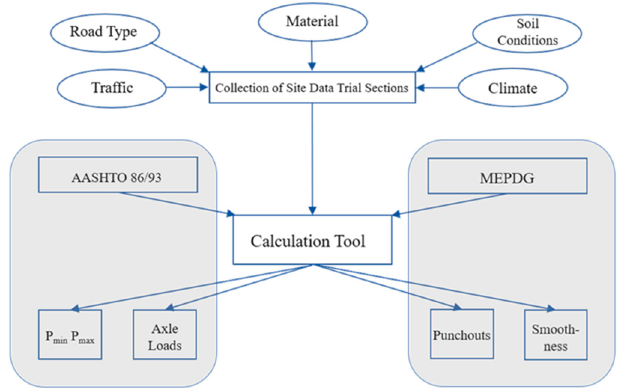
Figure 2. Methodology to compare AASHTO vs. examined tracks.